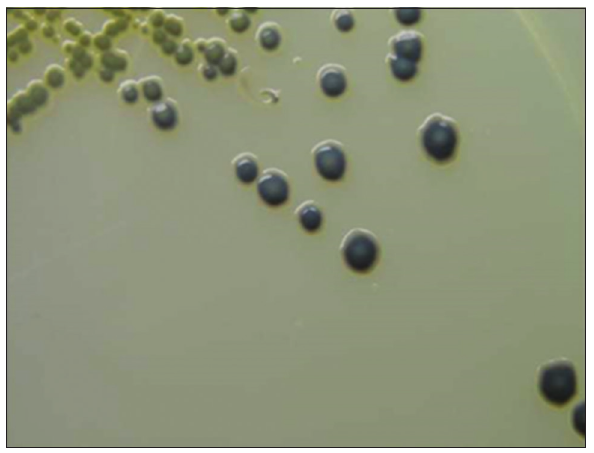
Figure-1: Typical jet back colonies of Staphylococcus aureus surrounded by white halo showing lecithinase activity on Baried Parker agar.